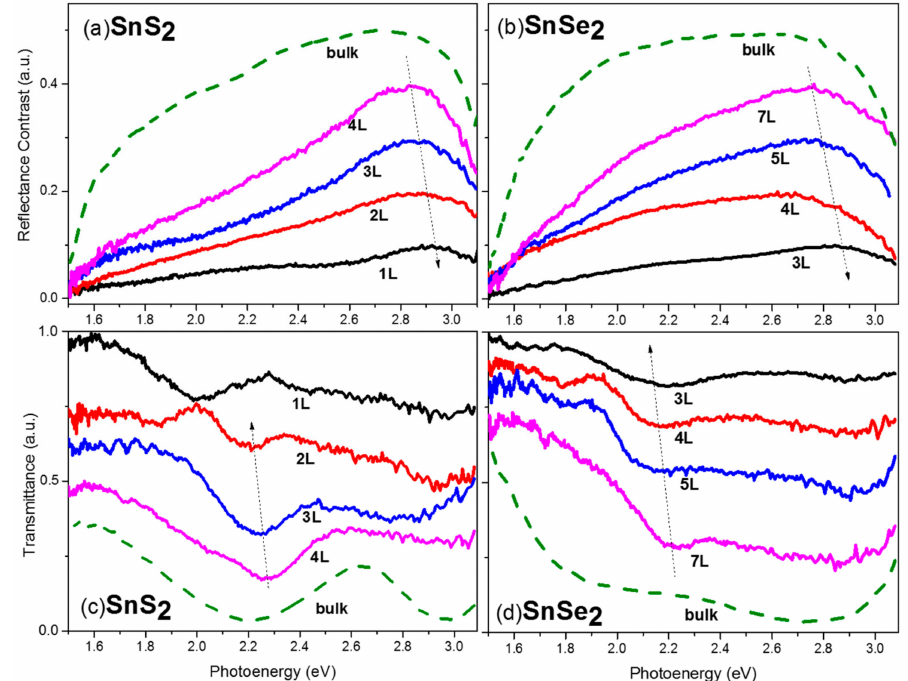
Figure 7. Reflectance contrast spectra of few-layer and bulk ( a ) SnS 2 and ( b ) SnSe 2 . Transmission spectra of few-layer and bulk ( c ) SnS 2 and ( d ) SnSe 2 . Some curves are shifted in the vertical axis for visual clarity. The thickness is labeled in the figures. The dotted arrow lines are guides for the